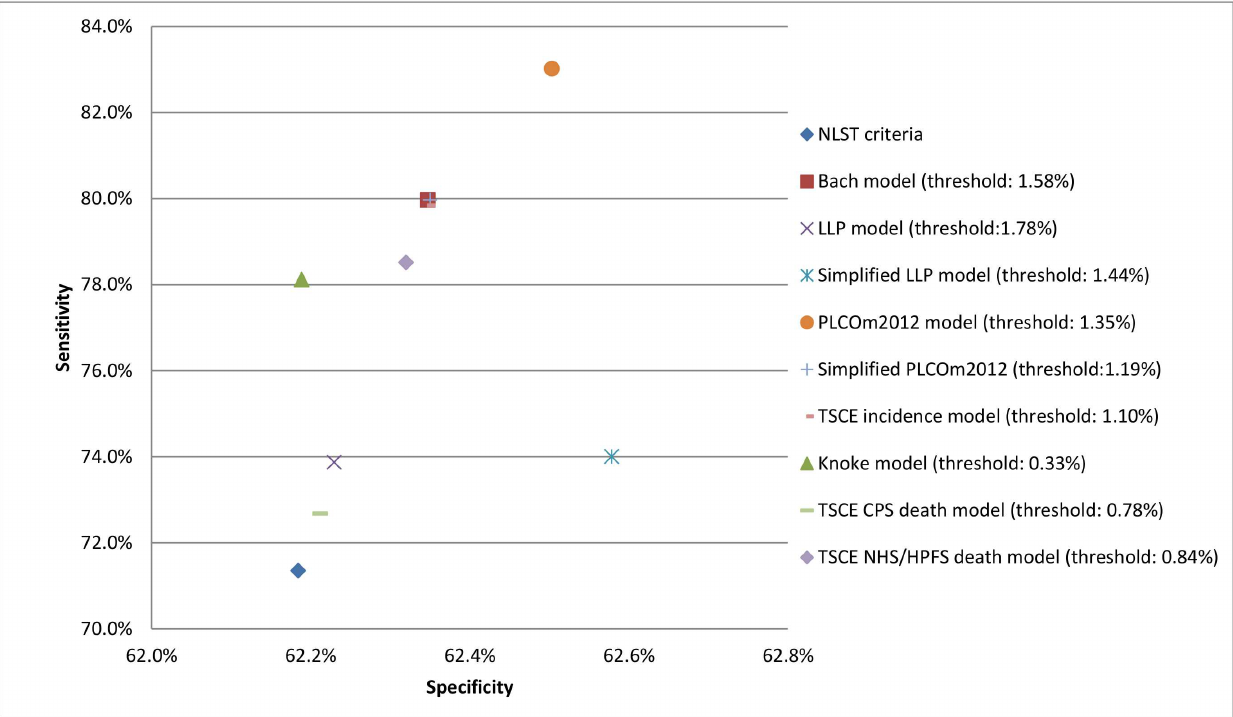
Fig 6. Sensitivity, specificity, and risk thresholds for the investigated risk prediction models and the National Lung Screening Trial criteria for 6-y lung cancer incidence in the Prostate, Lung, Colorectal and Ovarian Cancer Screening Trial chest radiography arm. CPS, Cancer Prevention Study; HPFS, Health Professionals Follow-upStudy; LLP, LiverpoolLung Project; NHS, Nurses’ Health Study; NLST, NationalLung ScreeningTrial; TSCE, Two-Stage Clonal Expansion.